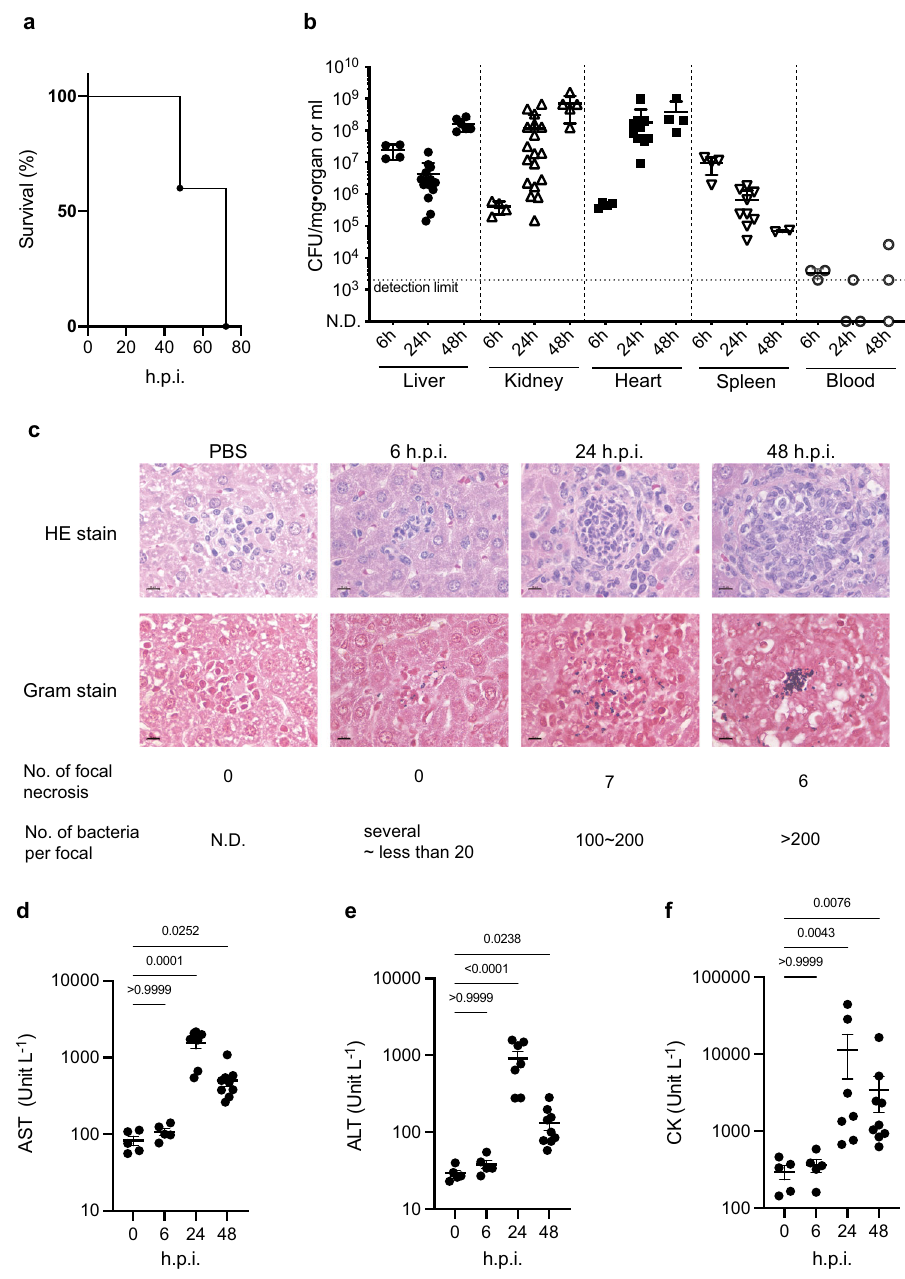
Fig. 2 Conditions of systemic S. aureus infection model in this analysis. a Survival of mice infected with S. aureus Newman strain. Bacterial cells (5.6 × 10 7 CFU) were injected into the tail vein ( n = 5). Data represent the mean ± SEM. b Number of S. aureus cells in each organ after infection with (5.3 × 10 7 CFU, n = 2 to 11). c Histopathological analysis of liver from mice infected with S. aureus Newman strain (6.8 × 10 7 CFU). Photographs are representative of the results for 2 mice. The bars in the pictures were indicated as 10 µ m. d – f Analysis of hematological parameters of infected mice. AST ( d ), ALT ( e ) and CK ( f ) parameters in the plasma collected from mice ( n = 5 for 0 and 6 h.p.i., n = 7 for 24 h.p.i. and n = 9 for 48 h.p.i.) infected with S. aureus Newman strain (6.8 × 10 7 CFU) were measured. Data represent the mean ± SEM and statistical analysis was performed using a Kruskal-Wallis test with Dunn ’ s multiple comparisons